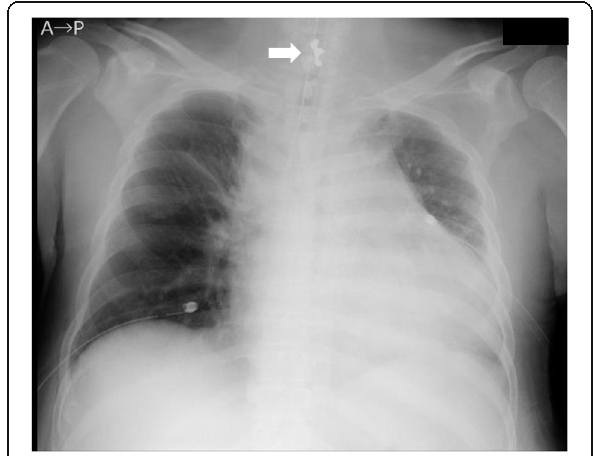
Fig. 1 A chest radiograph taken on POD 34. A foreign body was confirmed at the midline of the neck (arrow). POD, postoperative